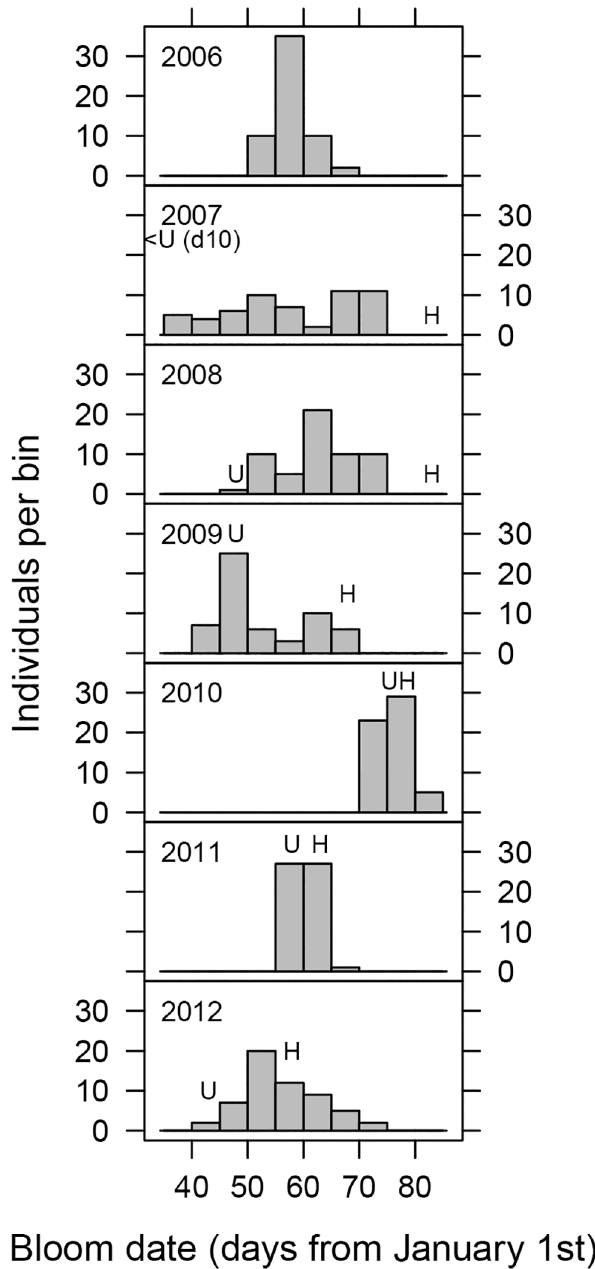
Fig 3. Histogram of bloom date phenotypes of F 2 progeny in seven seasons of observations. Bloom date is measured from January 1 st . Letters indicate grandparental phenotypes (H, ‘ Hakuho ’ ; U, ‘ UFGold ’ ).